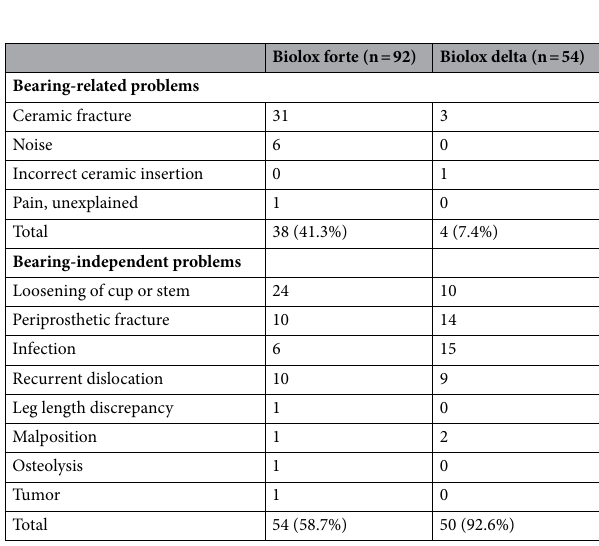
Table 3. Comparison on reasons for CoC revisions between third and fourth